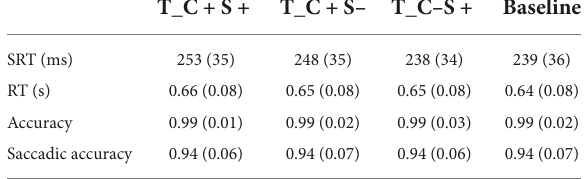
TABLE 2 Mean saccadic reaction time (ms) and reaction time (s) and accuracy and saccadic accuracy for all condition of Exp. 1B (standard deviations are within parentheses).